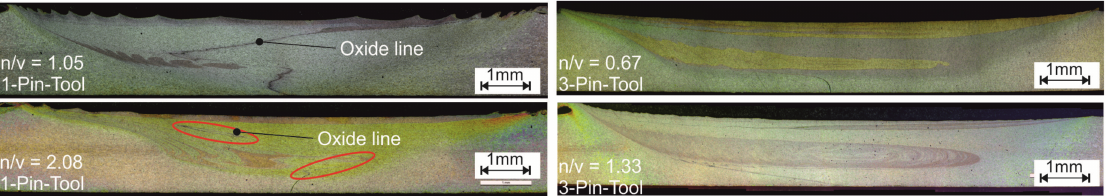
Figure 2. Comparison of a cold (1.05/0.67) and a warm (2.08/1.33) welding seam of a tool with one pin and a multipin-tool, etched with NaOH